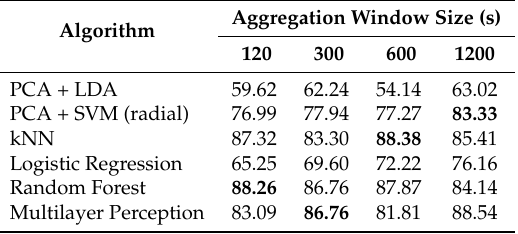
Table 10. Effect of the length of the aggregation window on classification accuracies.